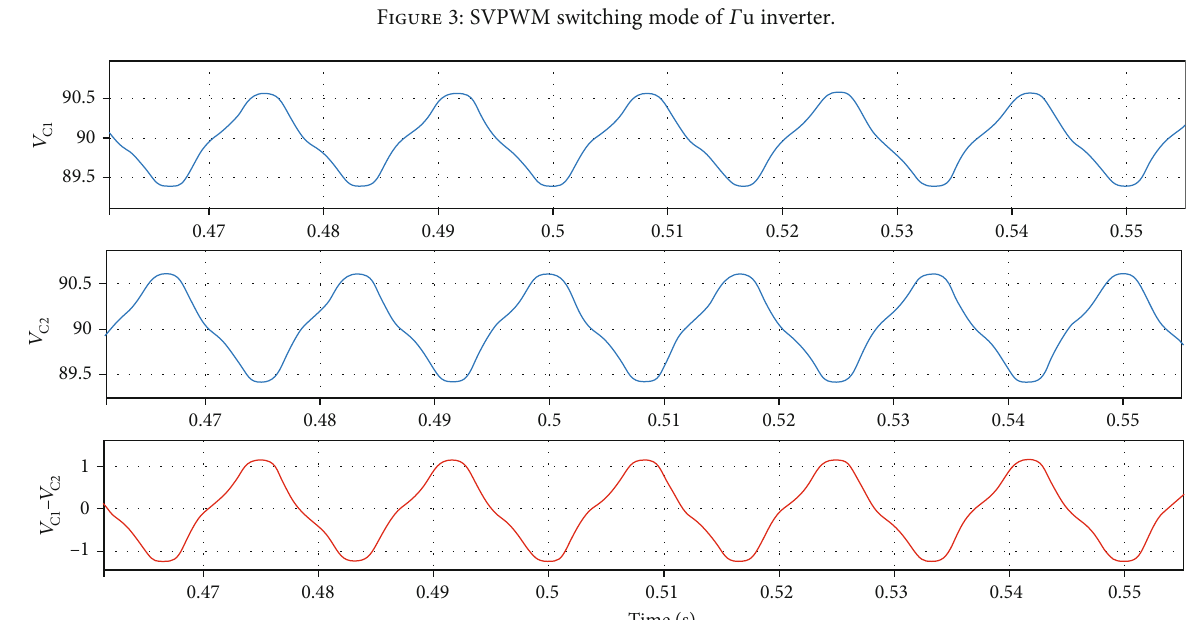
Figure 4: DC link capacitor voltage range without